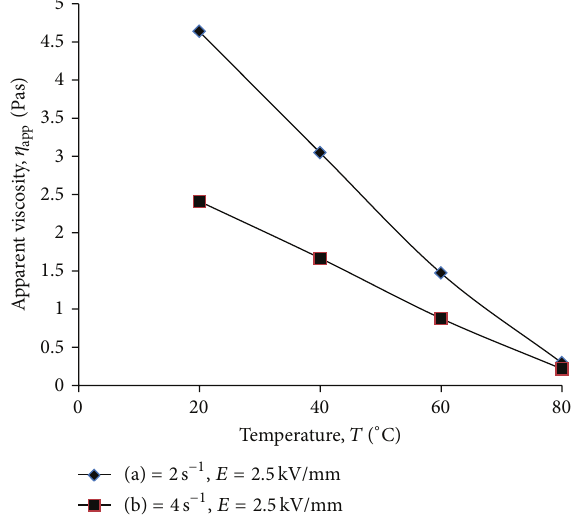
Figure 3: Viscosity (Pas) versus temperature, ( ∘ C) for (a) = 2 s −1 , 𝐸 = 2.5 kV/mm, and (b) = 4 s −1 , 𝐸 = 2.5 kV/mm.